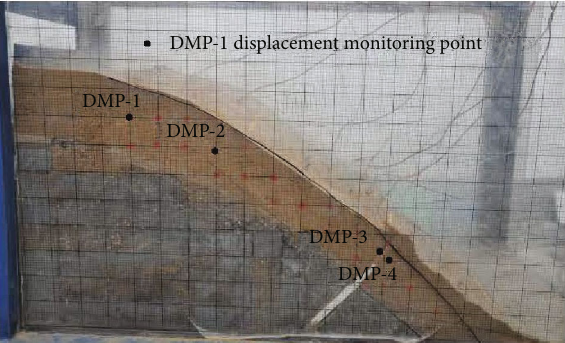
Figure 5: Displacement monitoring points on landslide